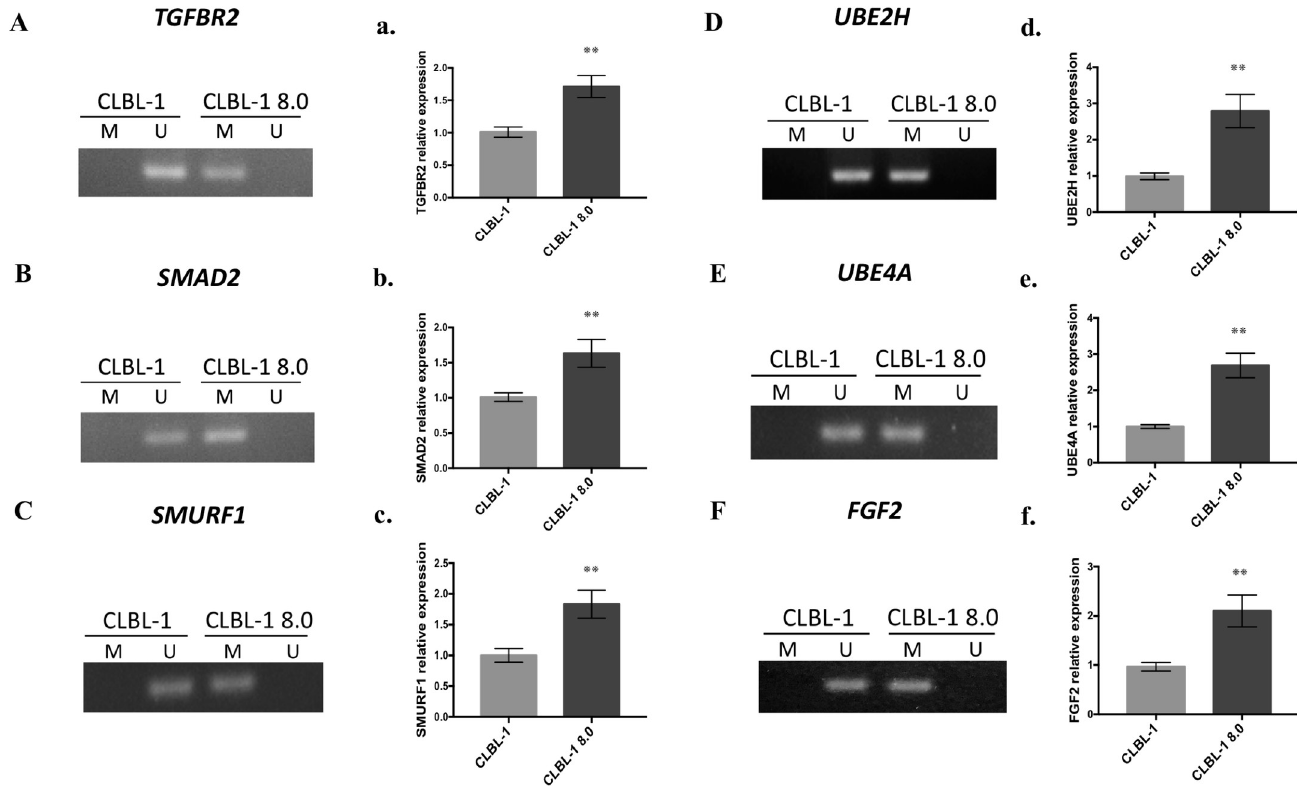
Fig 4. DNA hypermethylation in gene-body regions of TGFBR2 , SMAD2 , SMURF1 , UBE2H , UBE4A , and FGF2 increased their mRNA expression levels in CLBL-1 8.0. (A-F) DNA methylation of these genes analyzed by MSP. Primer pairs were designed to amplify methylated (M) or unmethylated (U) genomes. (a~f) The mRNA expressions of these genes in CLBL-1 and CLBL-1 8.0 cells. GAPDH and OAZ-1 were used as internal controls and showed similar results. Data standardized by GAPDH alone were presented. Error bars represent the SEM of the results from 3 independent experiments. �� P < 0 . 01 .